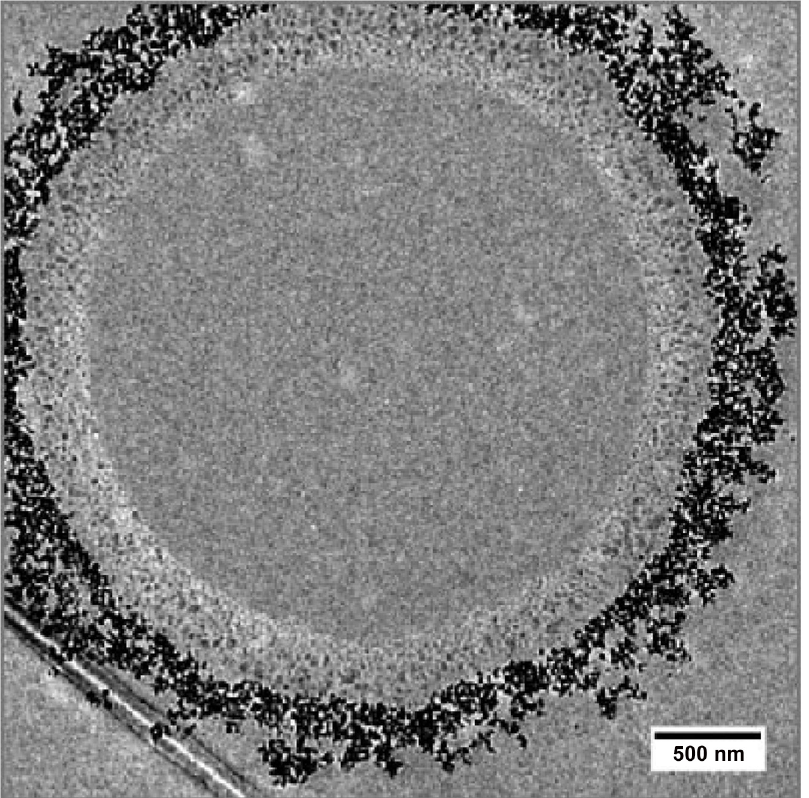
Fig 6. Transmission electron microscopy image of a PVA microbubble. The bubble is coated with iron- oxide nanoparticles, manufactured by Surflay nanotec GmbH, Berlin, Germany. Image courtesy Johan Härmark, School of Technology and Health, KTH Royal Institute of Technology,